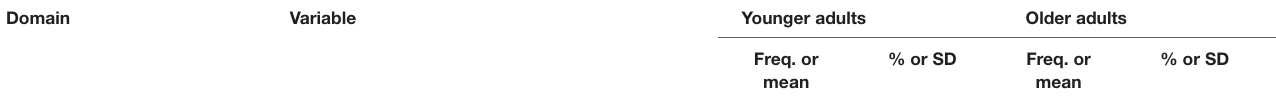
TABLE 3 | Descriptive statistics and bivariate tests of the study variables used in the final models: environmental variables (survey and GIS). Domain Variable Younger adults Older adults